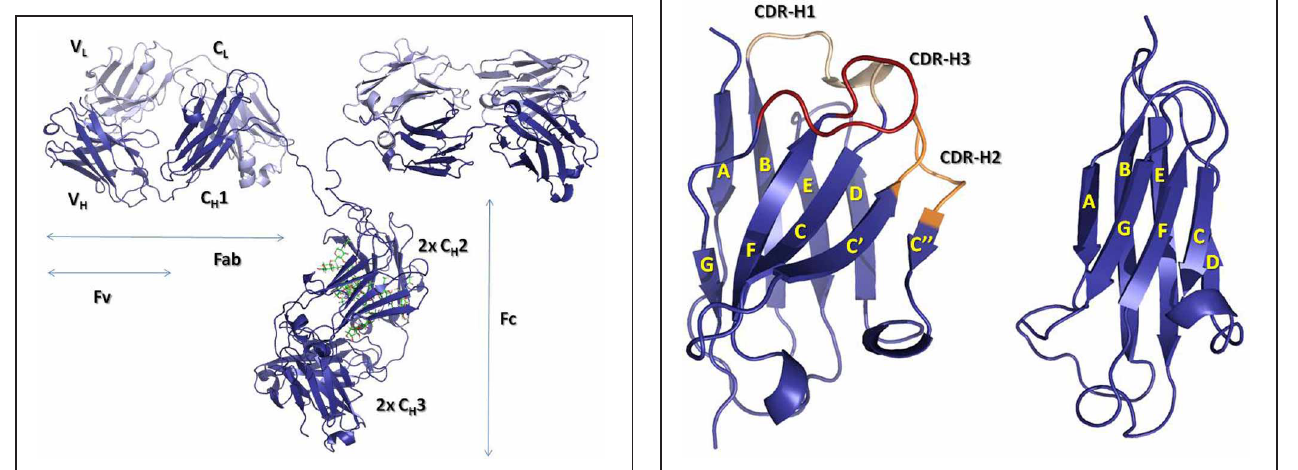
FIGURE 1 | Ribbon representation of an intact IgG molecule (PDBID: 1IGT). The heavy chains are shown in dark blue, while the Light chains are colored in light blue. The carbohydrate moieties attached to the C H 2 domains are represented with sticks. The figure was produced using PyMol (DeLano, 2002. The PyMOL molecular graphics system . Delano Scientific, San Carlos, CA).